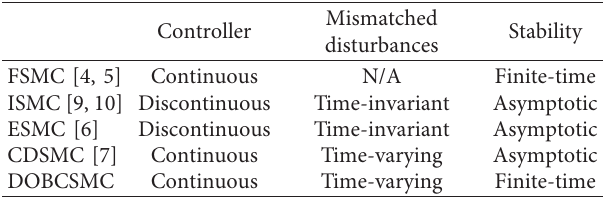
Table 1: Features of FSMC, ISMC, ESMC, CDSMC,